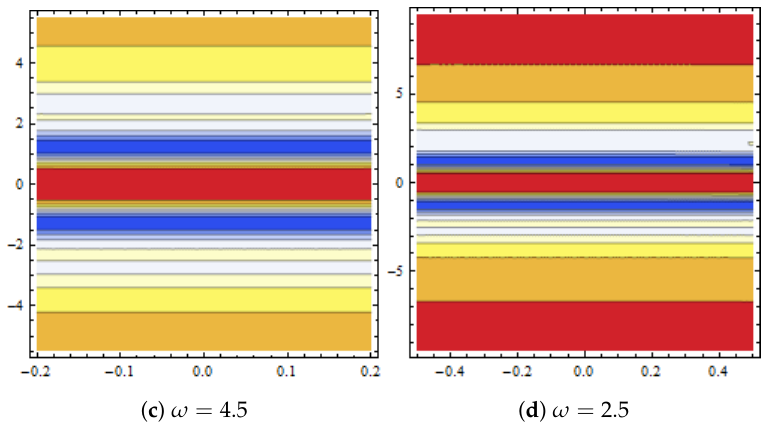
Figure 25. Graphical presentation of u ( x , t ) in Equation (62) presented with β 1 = 0.5, β 2 = 1.2, β 3 = 2.5, ζ = 0, l 1 = 3, l 2 = 0.1, l 4 = 2, Q = 5, r 1 = 1.5, r 2 = 3.1, w 2 = 1.1, w 3 = 2.3, w 4 = 0.9 and φ = 1.2. ( a , b ) show 2D plot and ( c , d ) show contour graph.